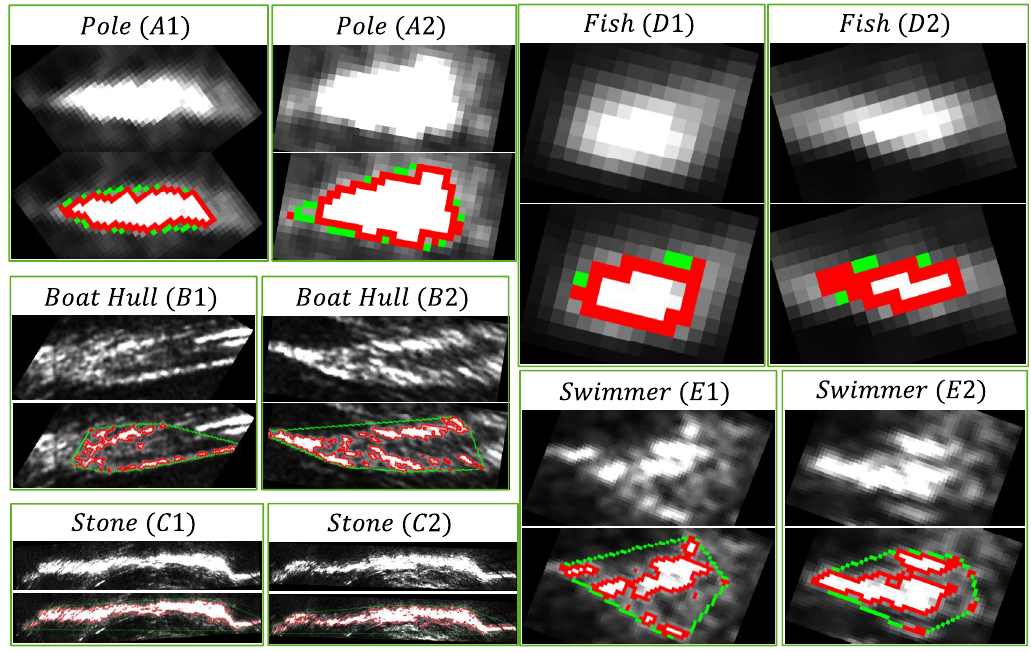
Figure 8. Segmentation results using the parameters of Table 2. Pixels in red represent the segment contour, and pixels in green represent the convex hull. The information extracted from each segment is shown in Table 4. All images are in Cartesian coordinates. This way, we can direct extract geometric information from the segments.